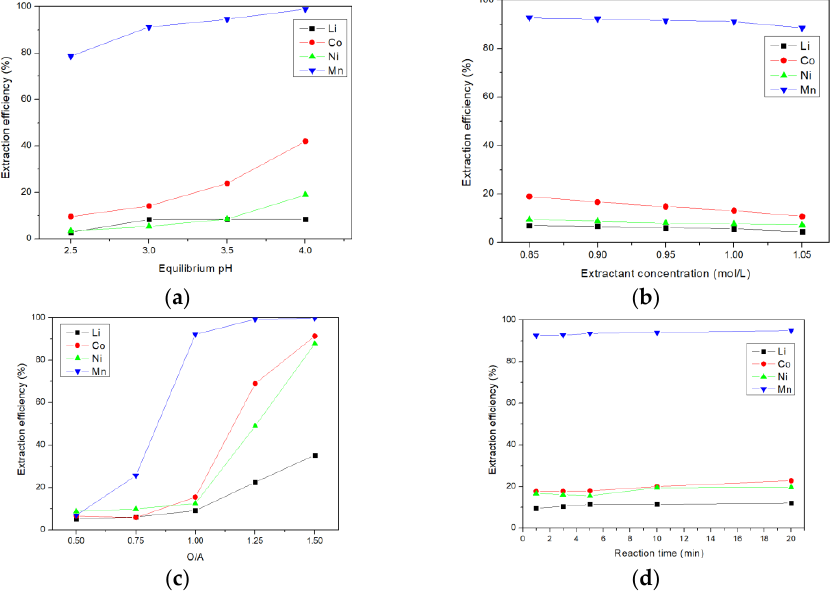
Figure 2. Effects of ( a ) pH ([D2EHPA] = 1.0 M, O/A = 1, t = 15 min), ( b ) extractant concentration (pH = 3.0, O/A = 1, t = 15 min), ( c ) oil – water ratio (pH = 3.0, [D2EHPA] = 1.0 M, t = 15 min), and ( d ) reaction time (pH = 3.0, [D2EHPA] = 1.0 M, O/A = 1) on manganese extraction. Table 3. The relationship between the equilibrium pH and separation coefficient. Equilibrium pH